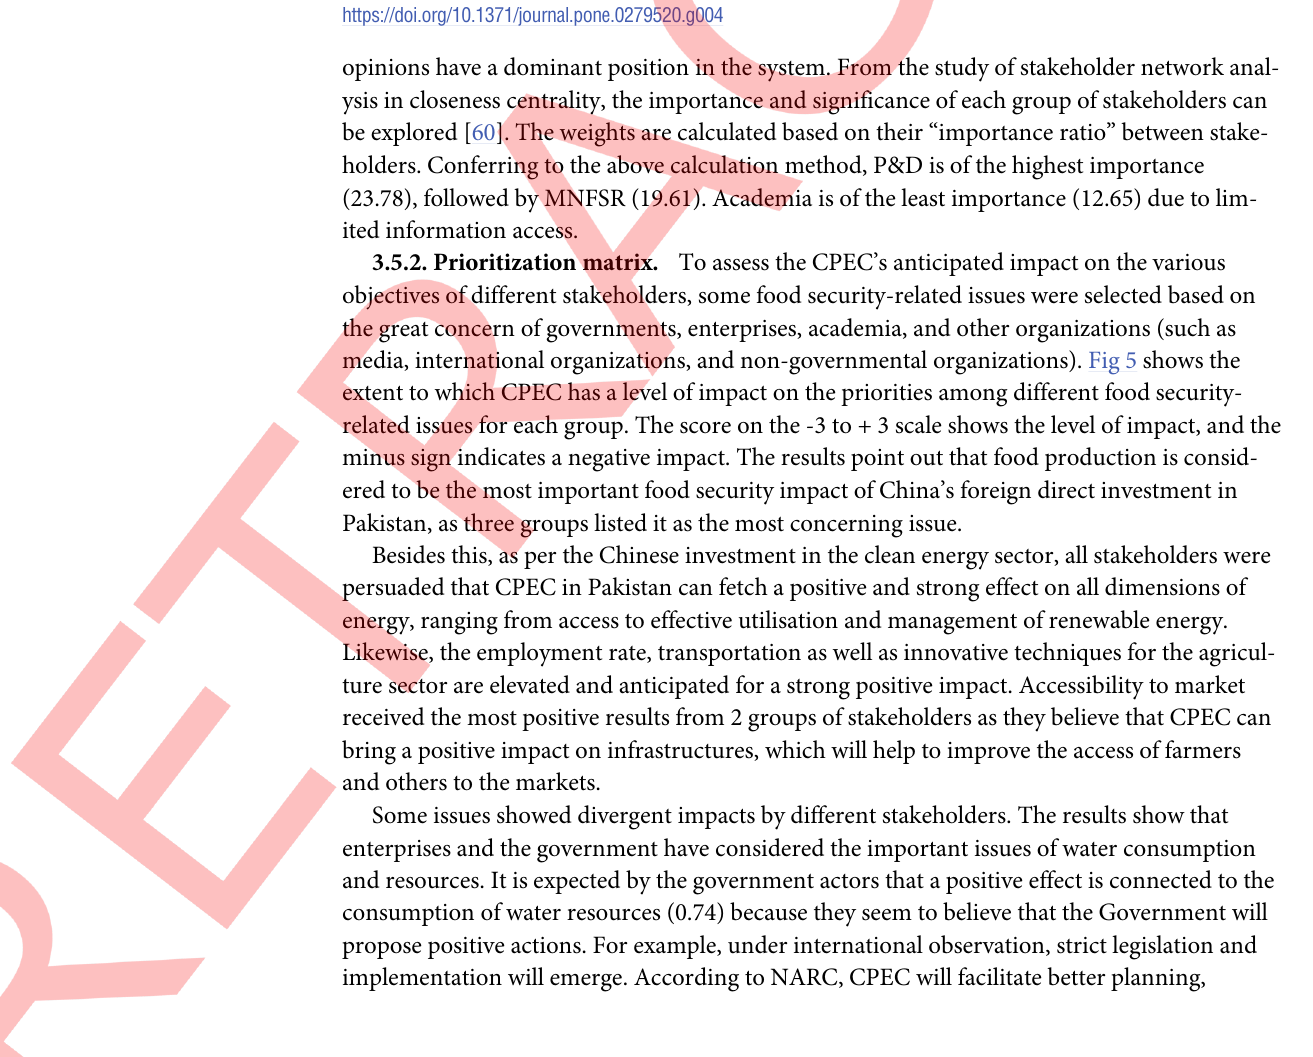
Fig 4. The social network for CPEC with stakeholder weights (closeness degree between the stakeholders showed scores from 1 to 5 (lowest to highest). Notes: This figure projects the groups (sets) having contact with stakeholders and pointed out in the questionnaire apart from